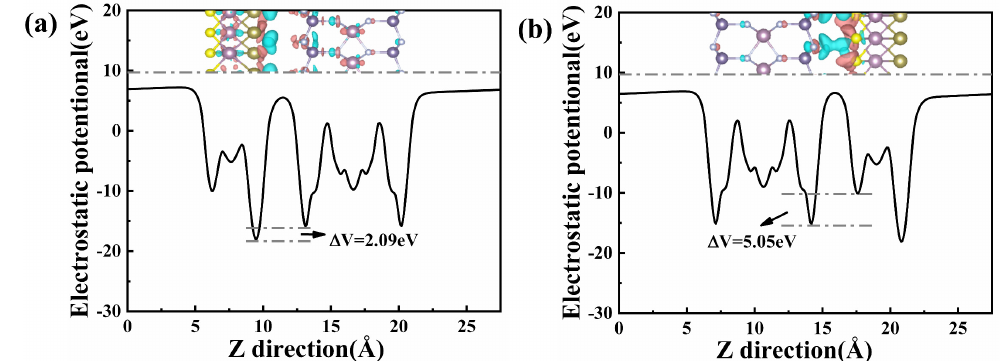
Figure 3. The electrostatic potential diagram in ( a ) Te 4 –MoSTe/MoGe 2 N 4 vdWH and ( b ) S 4 – MoSTe/MoGe 2 N 4 vdWH. The top inset shows the differential charge density. The pink and blue colors indicate electron accumulation and loss, respectively. The isosurface value is 0.0002 eVÅ − 1 .